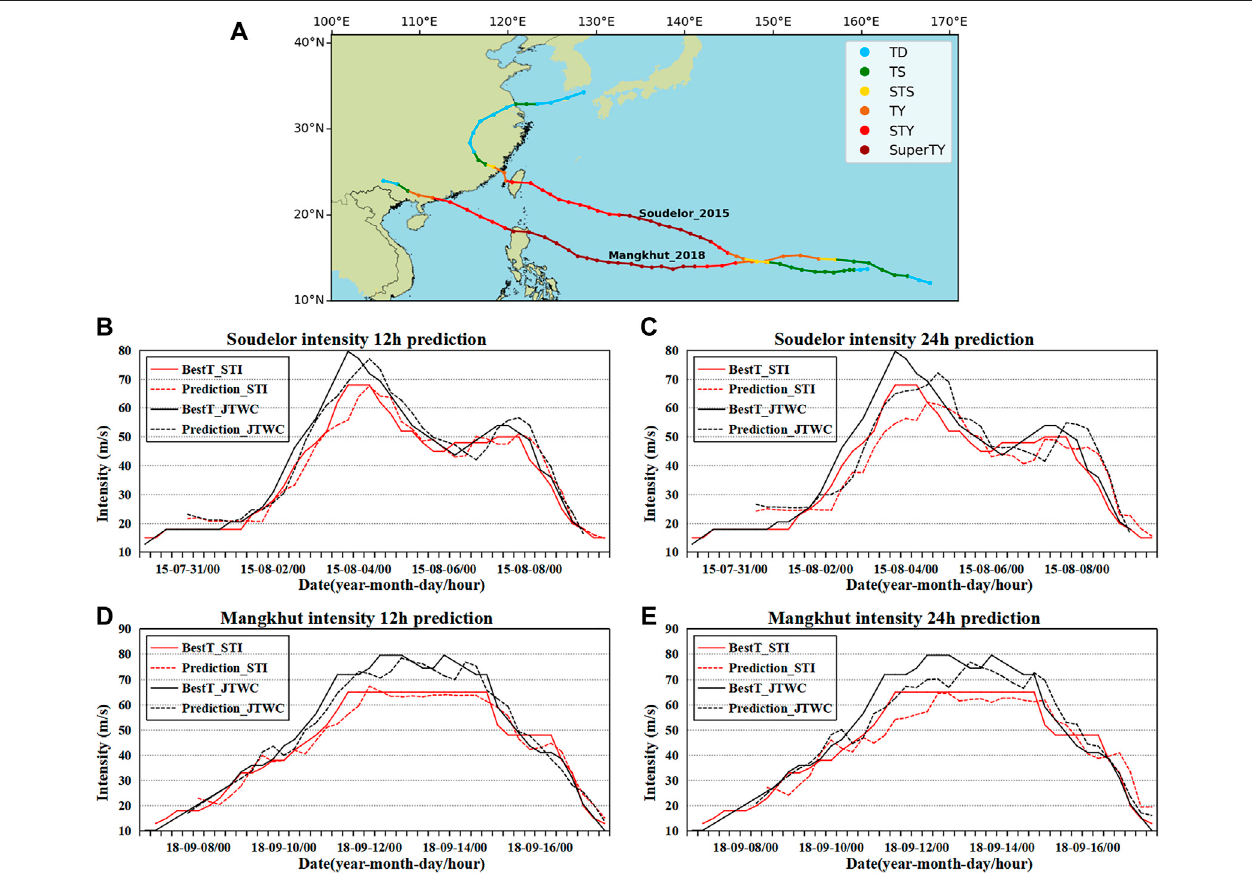
FIGURE 10 | (A) The tracks of Soudelor (201513) and Mangkhut (201822) based on the STI best track data; the comparison of the time series of Soudelor ’ s intensity values from the STI and JTWC best track data and the intensity prediction by the GBRT model by (B) 12-h and (C) 24-h lead time forecasts, respectively; the comparison ofthe timeseriesofMangkhut ’ sintensityvaluesfrom theSTIand JTWCbesttrack dataandtheintensityprediction bytheGBRTmodelby (D) 12-hand (E) 24-h lead time forecasts, respectively.